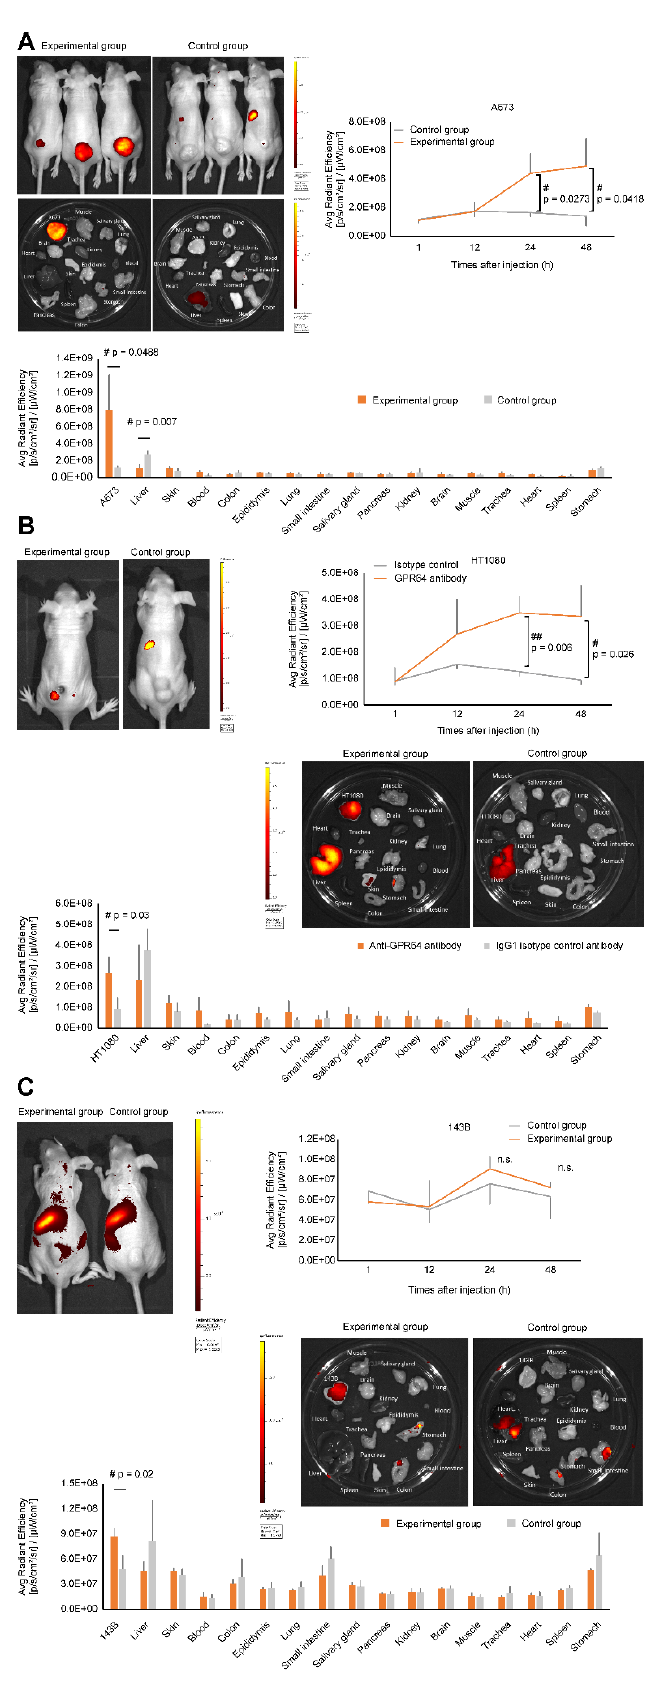
Figure 7. In vivo near infrared (NIR) optical imaging of human sarcoma cell xenograft-bearing